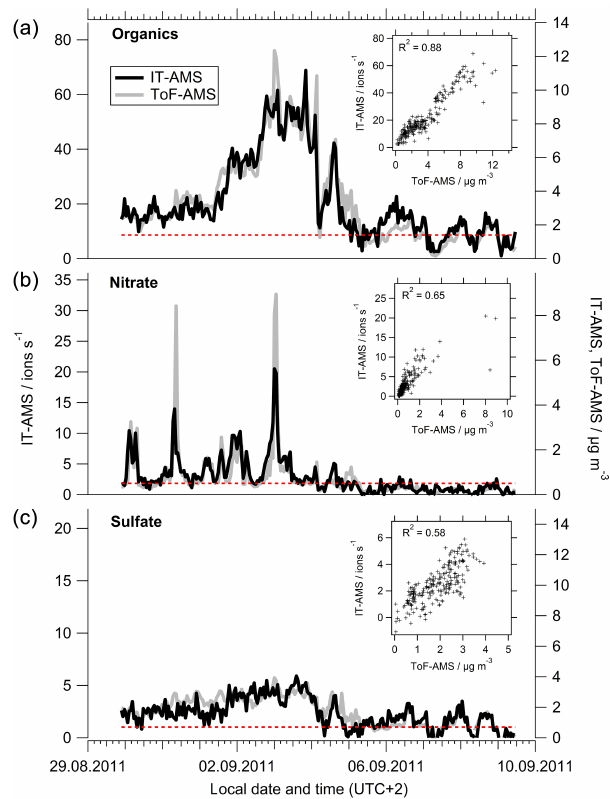
Figure 3. Comparison of 1h averaged time series of organics (a) , nitrate (b) , and sulfate (c) measured with the IT-AMS (left and right axes for ion rate and mass concentrations, respectively) and the ToF- AMS (right axis) during 11-day-long ambient measurements. The inlays show the correlation of the respective time series and the associated squared Pearson’s correlation coefficient ( R 2 ) ; the IT- AMS detection limits are marked with red dotted lines. IT-AMS mass concentrations are calculated using the linear correlation with the ToF-AMS time series